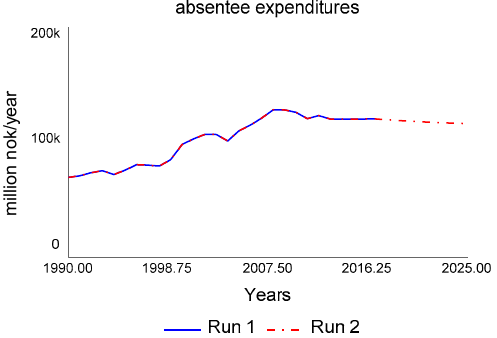
Figure 3. Total work absenteeism expenditures (Run 1 to 2017) and total work absenteeism expenditures without care work effects after 2017 (Run 2) in million NOK per year.